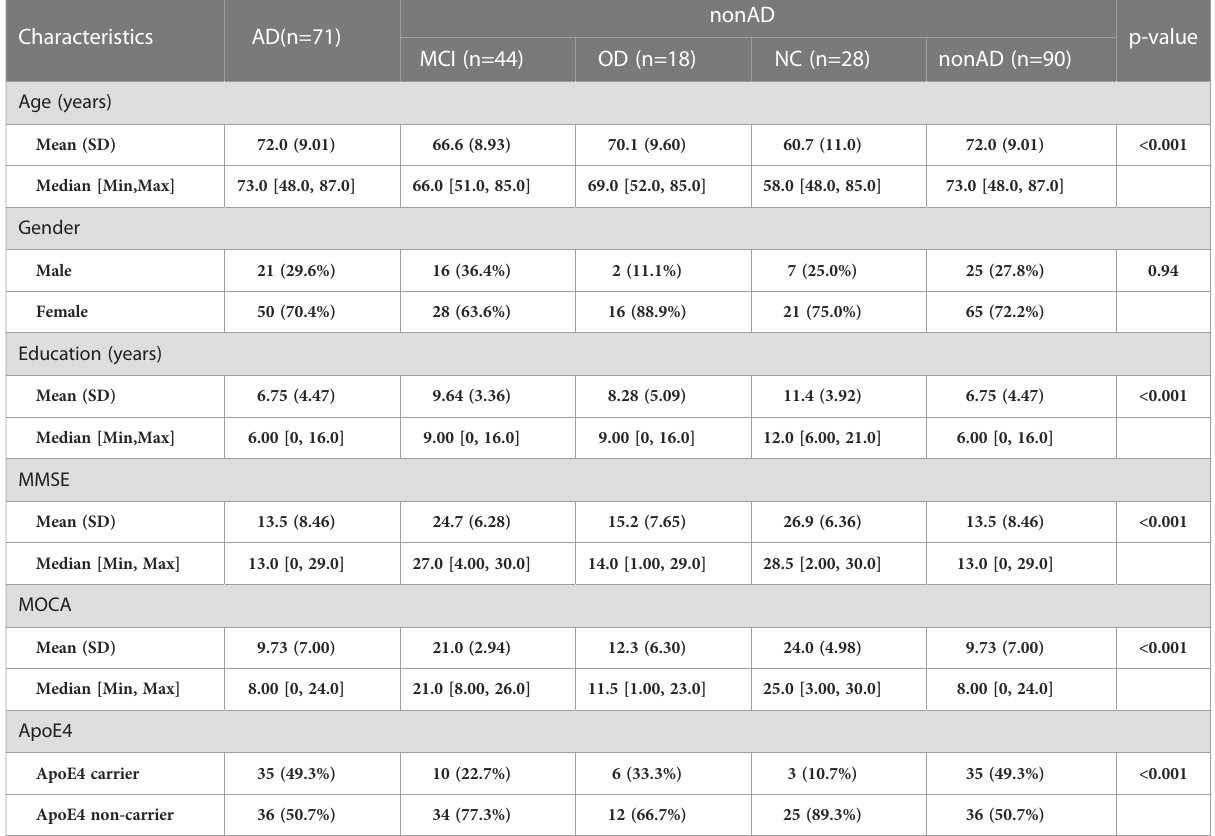
TABLE 1 Basic characteristics of study participants: This study recruited 71 patients with Alzheimer ’ s disease (AD), 44 patients with mild cognitive impairment (MCI), 18 patients with other dementia (OD), and 28 healthy people (Normal control, NC).